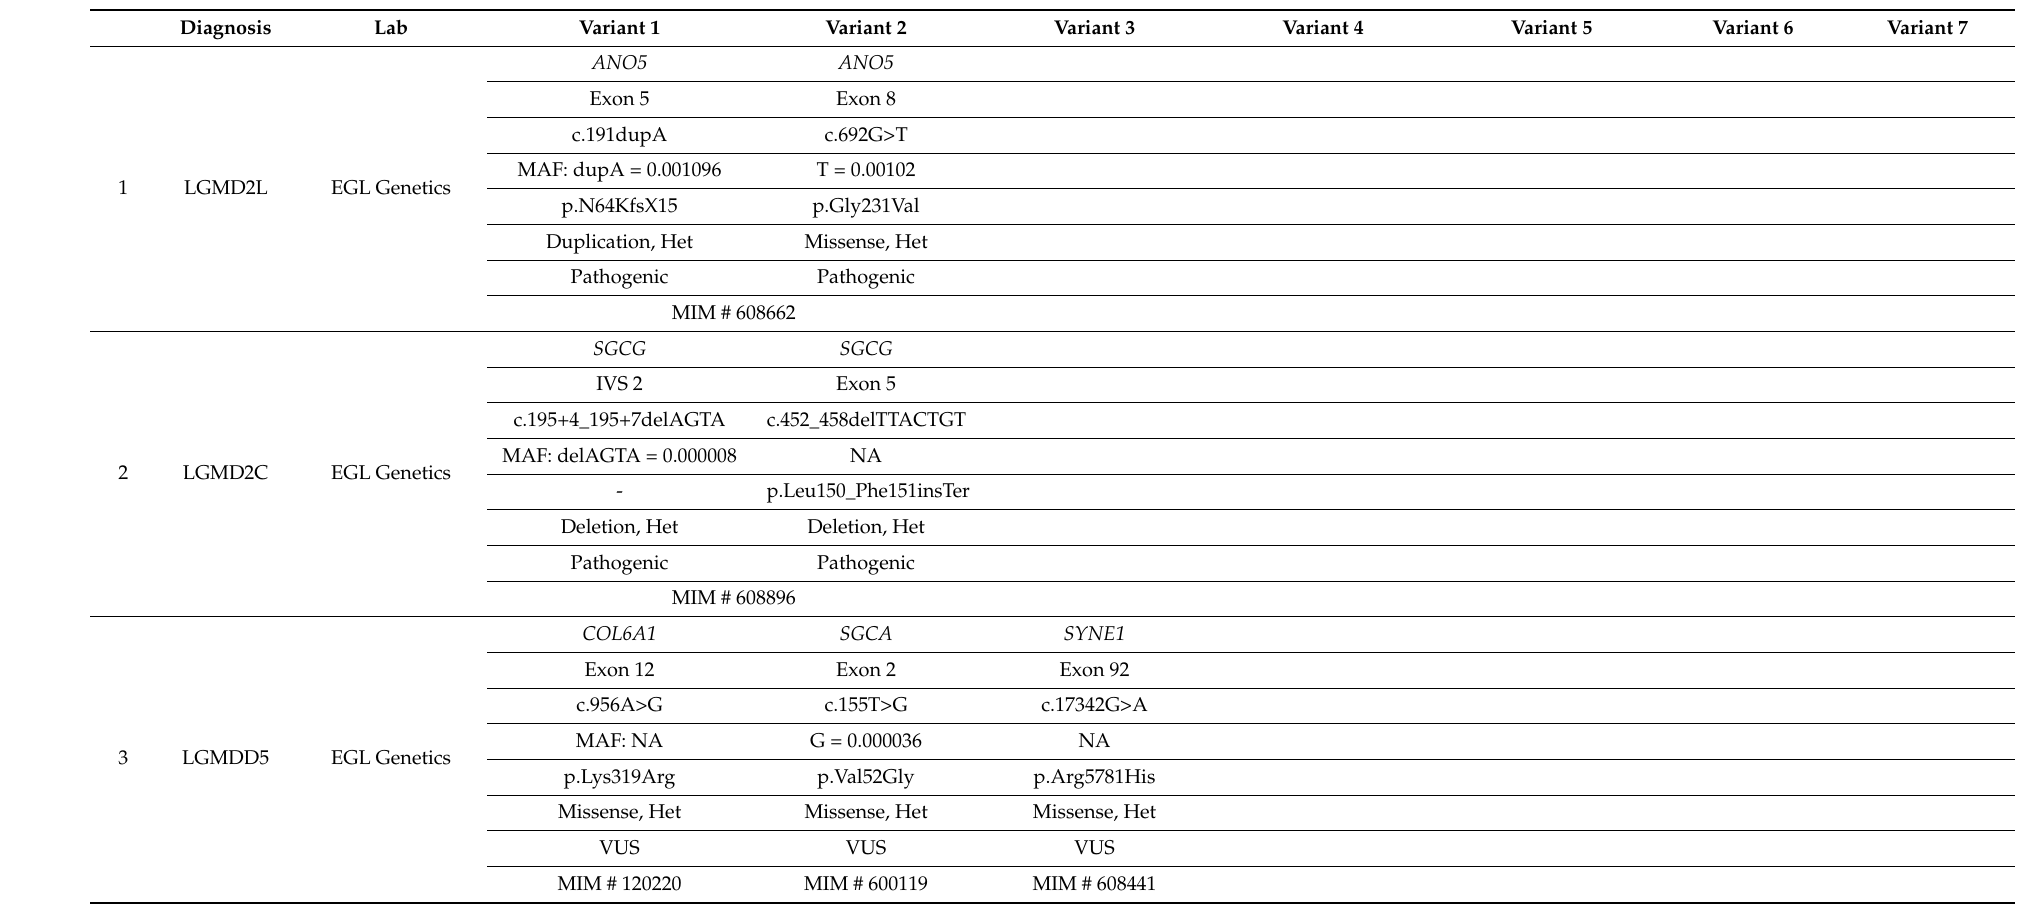
Table 3. Genetic characteristics of